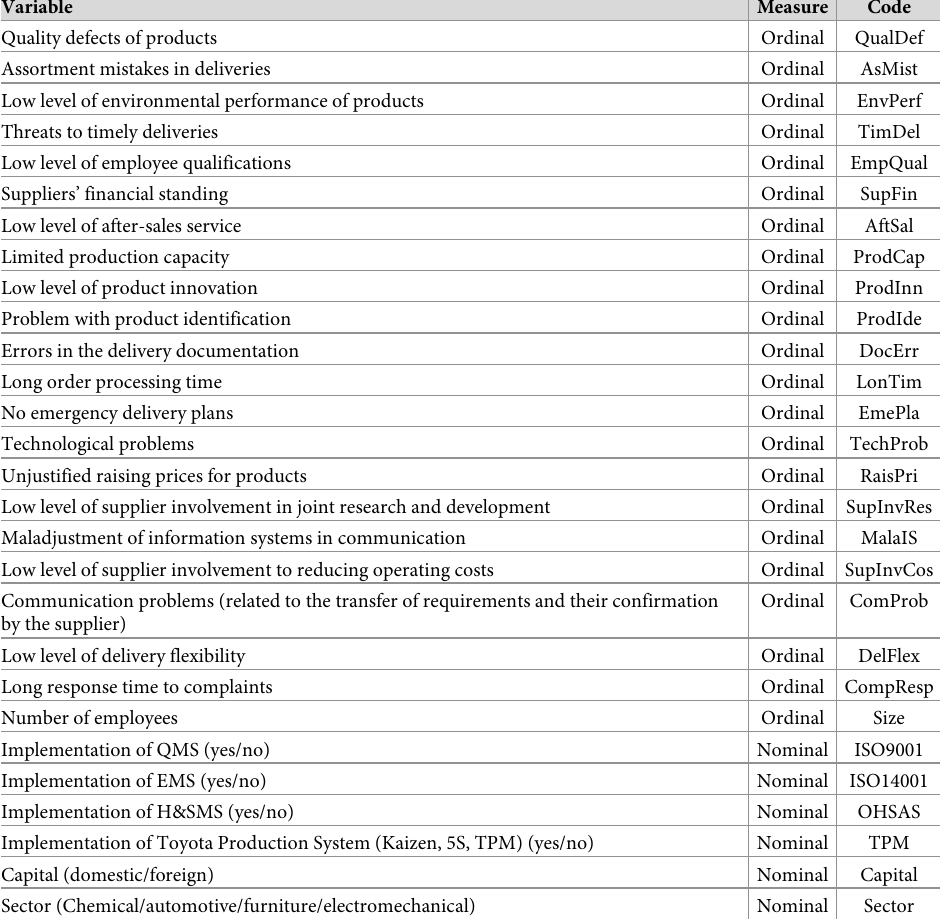
Table 1. Variables and their